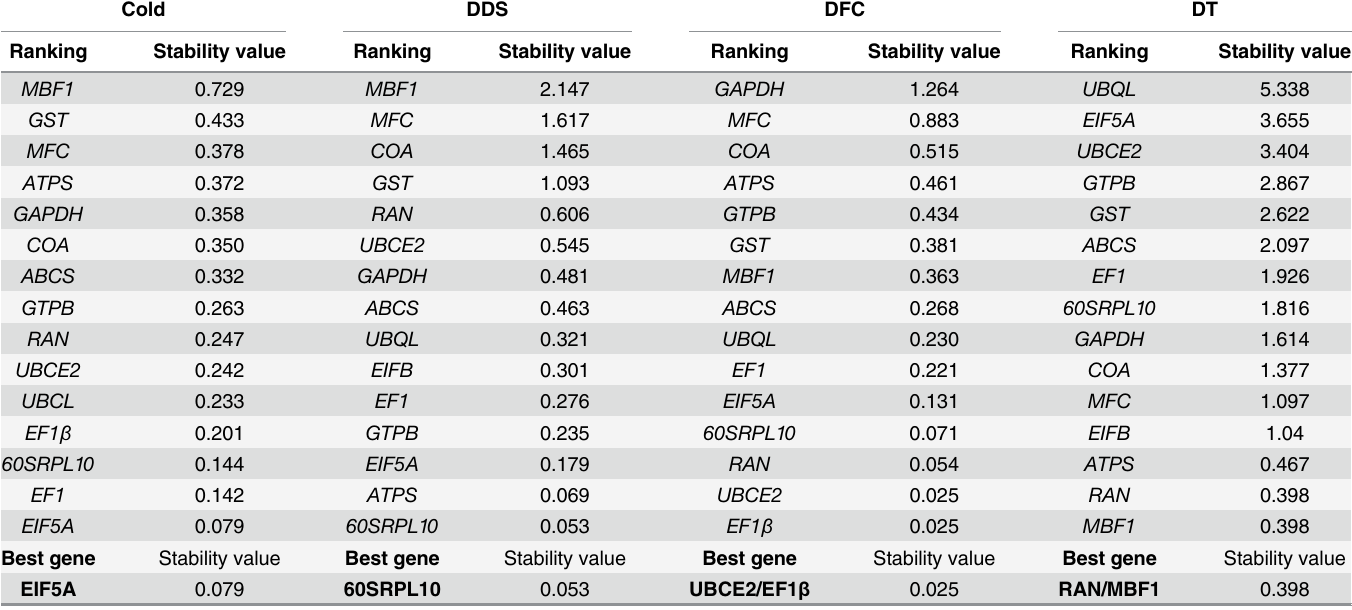
Table 6. Expression stability values of safflower RGs as calculated by NormFinder